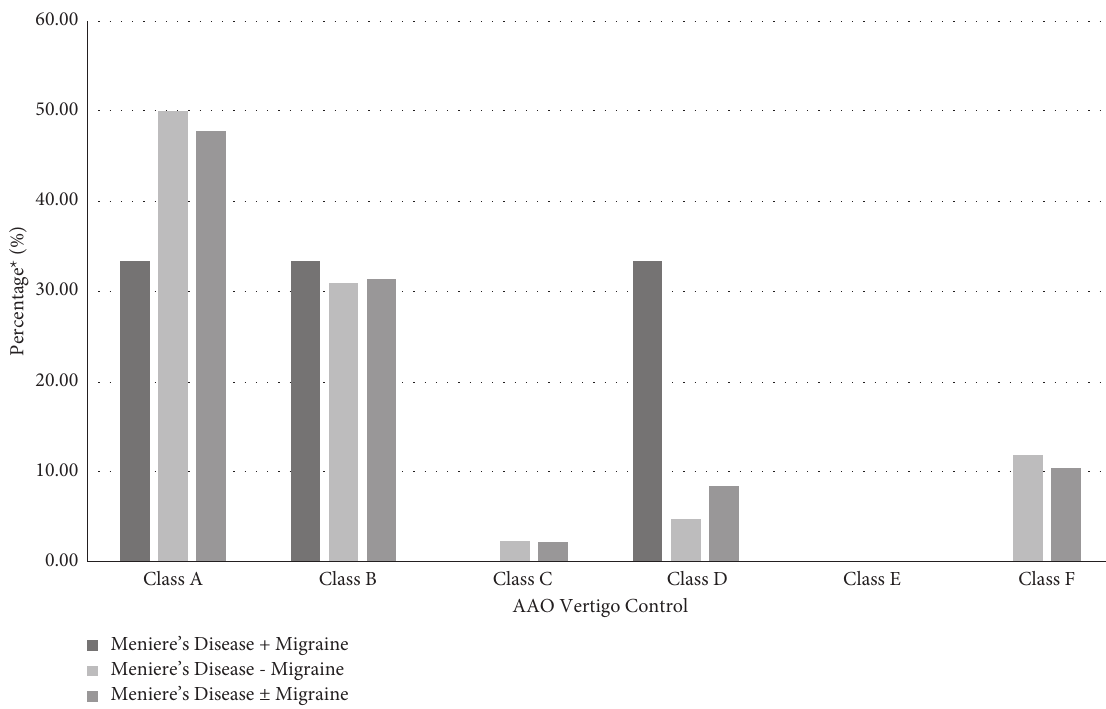
Figure 1: Vertigo outcomes following endolymphatic sac surgery. ∗ Based on specific population sizes for each respective patient category. See Tables 2 and 3 for numerical representation of results.